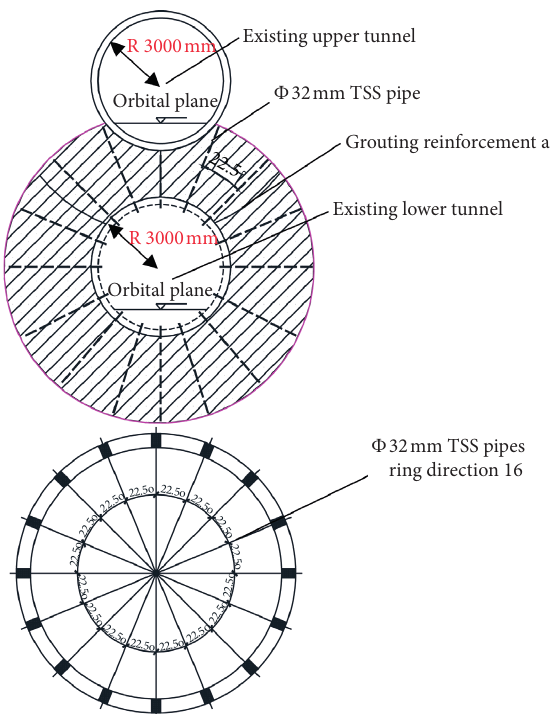
Figure 10: Grouting reinforcement plan for underpassing existing subway tunnel.